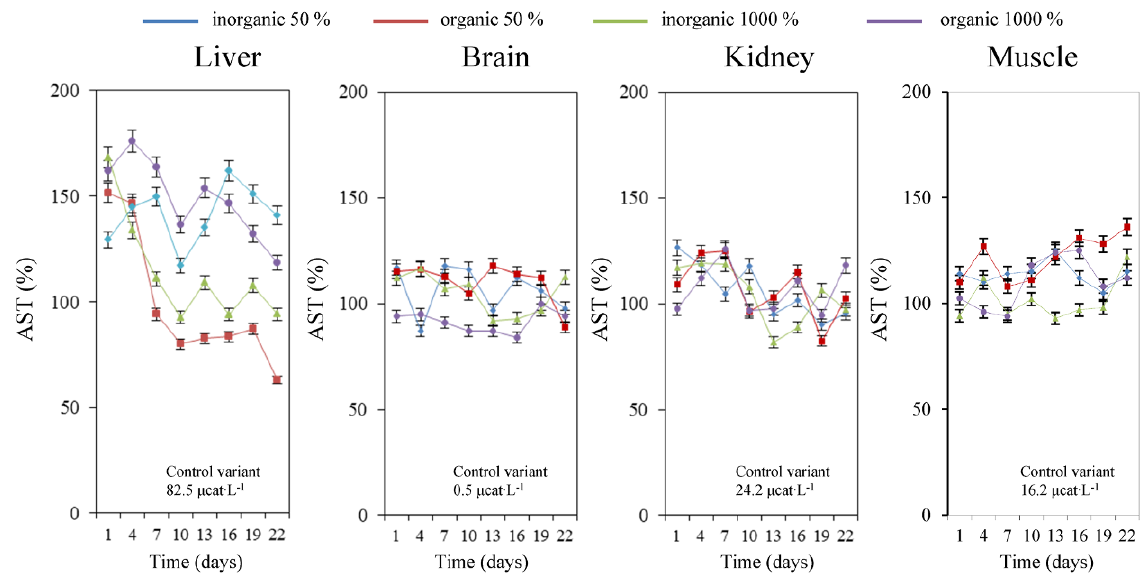
Figure 7. AST activity in the examined organs. The level was related to the controls. Error bars indicate standard error of mean for three specimens. AST was determined by spectrometric assay. The AST activity results were related to a control group and recalculated as a percentage of control. Control group was determined as a one hundred percent from individual values as follows: liver 82.5 μcat L -1 , brain 0.5 μcat L -1 , kidney 24.2 μcat L -1 and muscle 16.2 μcat L -1 .